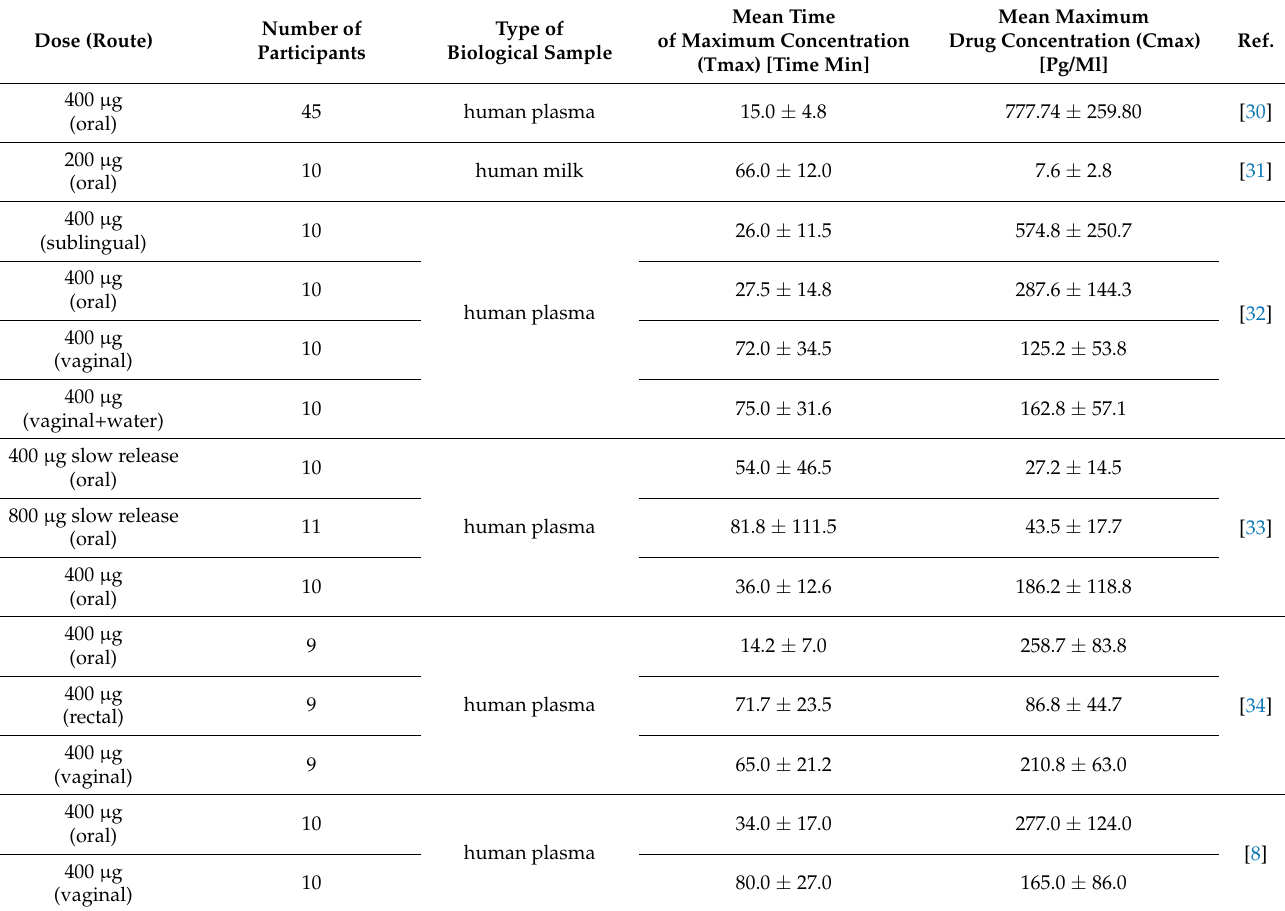
Table 3. Pharmacokinetic parameters of misoprostol acid in clinical